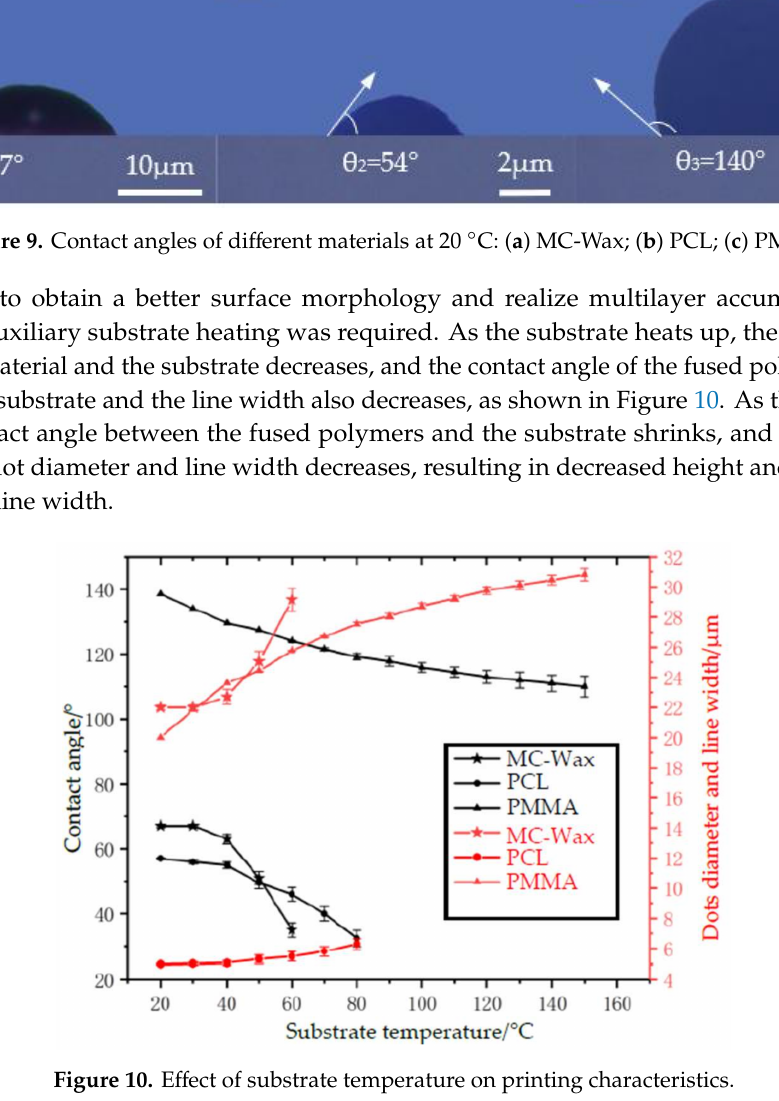
10 of 17 Figure 8. Schematic diagram of droplet deposition: ( a ) high-viscosity material deposition on the glass substrate; ( b ) low-viscosity material deposition on the glass substrate; ( c ) model of the contact angle on the substrate.